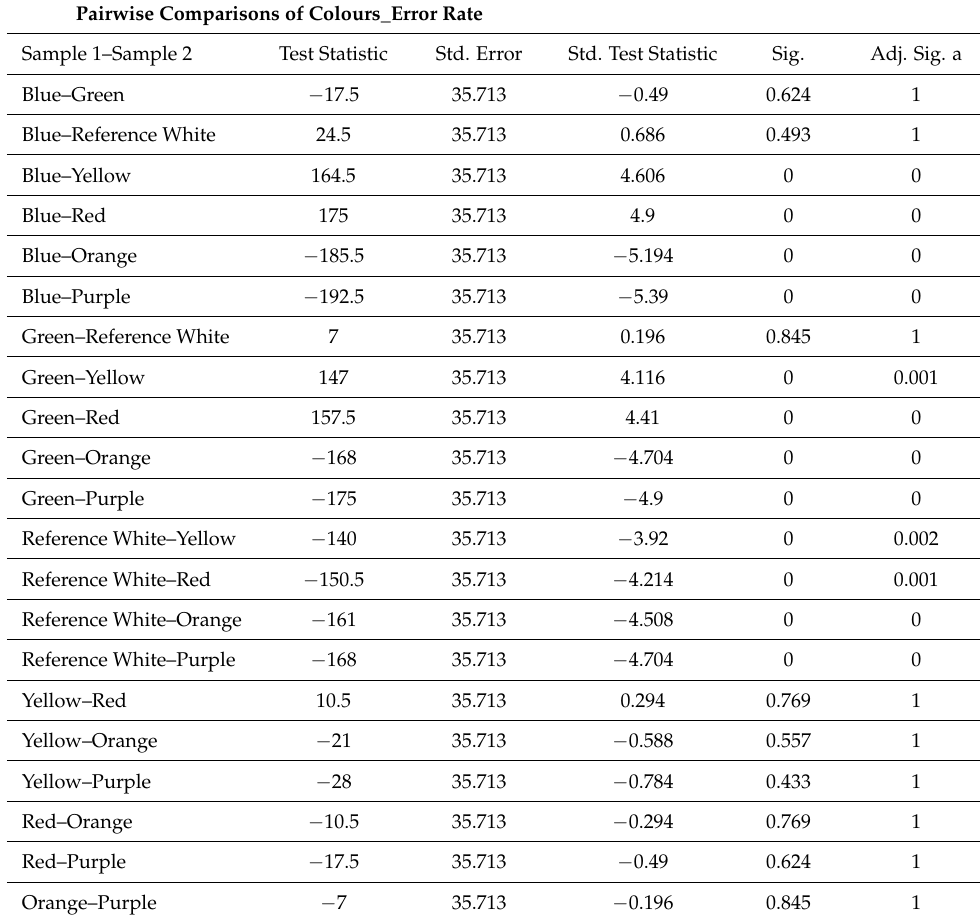
Table A11. Effects on error rate (general